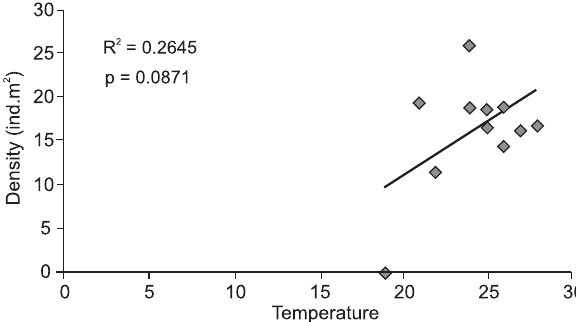
Figure 9. Temporal variation of temperature and population mean density (ind.m -2 ) of Scolelepis goodbodyi during the studied